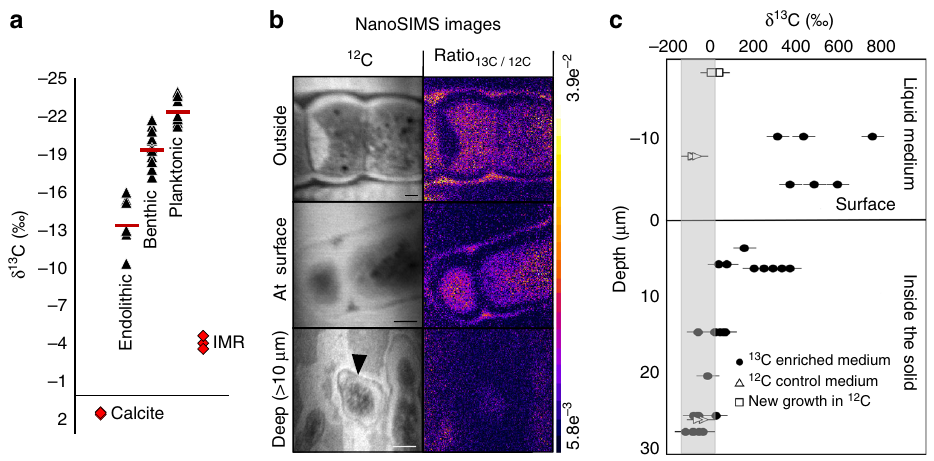
Fig. 2 Stable isotopic evidence for carbonate C fi xation. a Natural δ 13 C abundance in endolithic, benthic and planktonic cultured biomass of M. testarum strain BC008 obtained via CF-IRMS (Red bars indicate means of at least fi ve independent cultures). All means were signi fi cantly different (ANOVA, p < 0.06) from one another. The δ 13 C of potential sources of C (medium DIC and calcite substrate) are red closed diamonds. b , c correspond to cultures incubated with 13 C-DIC enriched medium, and started with very lightly bored inocula (Supplementary Fig. 2), so that the virtual totality of the biomass grew in the presence of the tracer. b Exemplary NanoSIMS images of cells analyzed for isotopic composition of organic C and obtained from different positions in a boring bed (scale = 2 µ m), with full quantitative data obtained from such images as a function of depth shown in c (Deep 12 C image — black arrowhead indicates a single cell of several observable in this image). Also included in c are control cells grown in medium without tracer (triangles), and cells grown after removal of the tracer (squares); the gray box represents δ 13 C values indistinguishable from background using this technique. Error bars equal one s.d. IMR = standard marine BC008 growth medium. DIC: dissolved inorganic yields of planktonic biomass ( p < 0.01; Fig. 1e) were expectedly